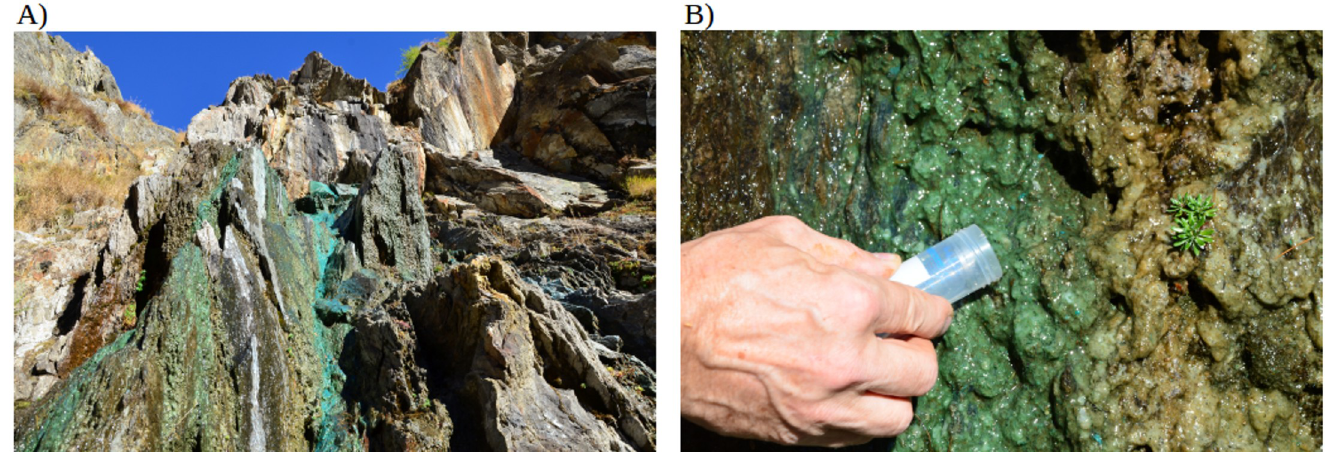
Fig 1. Biomat spring in the Greina region, Camadra di Fuori / Sassina location in the Camadra valley. This spring is well known in the region because of the green-turquoise colour of the biomat on the rocks [26]. The geographical position of the biomat spring is: CH1903+ / LV95 2’715’235, 1’160’895, at an elevation of 1’726 m asl. A) Overview of the biomat spring (summer 2015). B) Details of the